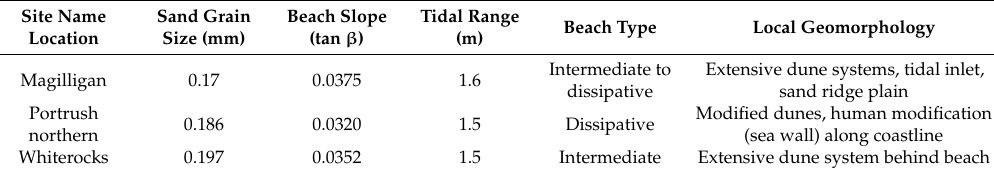
Table 1. Main attributes of selected